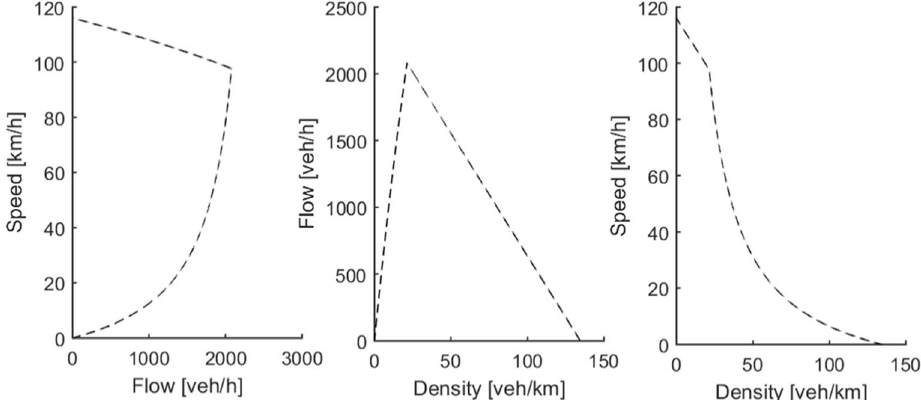
Fig. 3 Speed-flow-density behavioural relationships adopted in